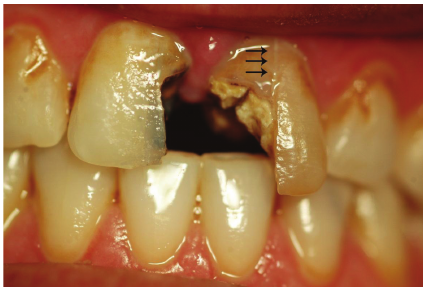
Figure 3: Arrows showing the fracture line on the buccal surface of the root.